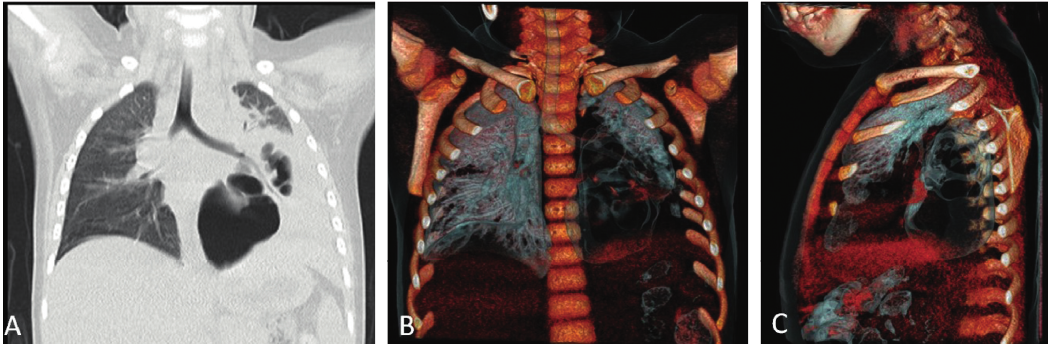
Figure 6: Noncontrast frontal view chest CT: lung window (a) and virtual bronchography (volume-rendered display) for visualization of airways (b, c).